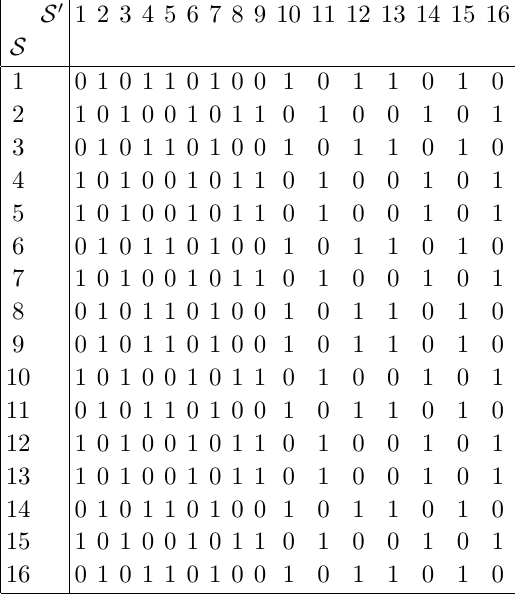
(cid:2) P with di(cid:11)erent boolean factors. [2] [4]